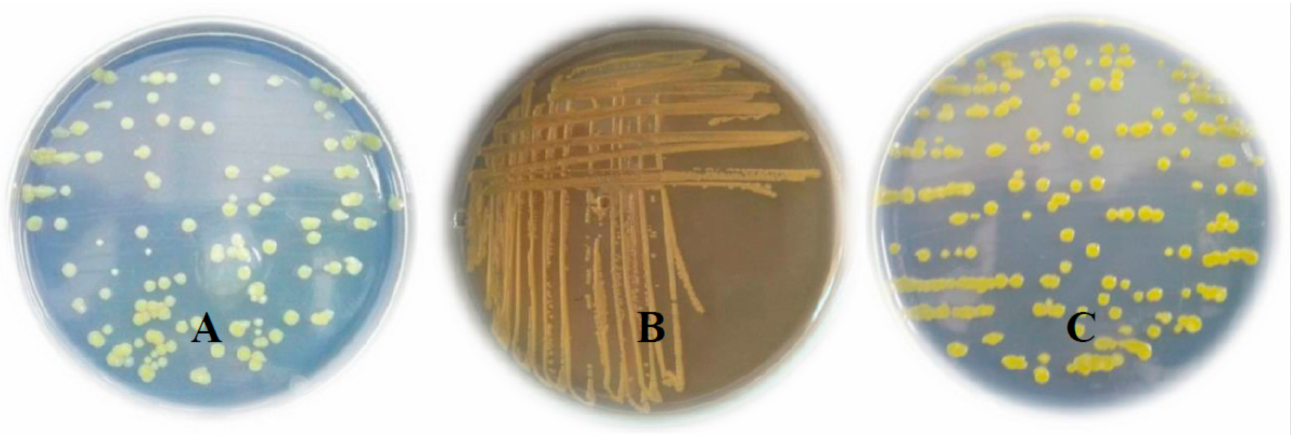
Figure 1. Pepper plant leaves with bacterial spot symptoms have brown lesions surrounded by yellow halos, from which bacteria were isolated.